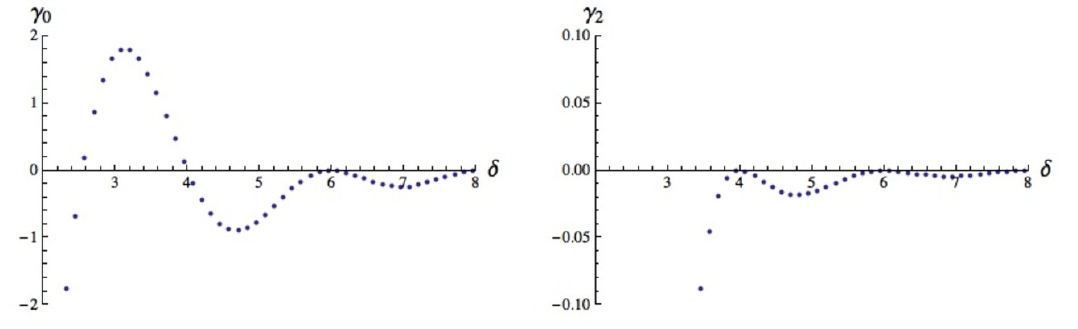
Figure 2 . Contribution to the anomalous dimension (cid:13) 0 ; 0 and (cid:13) 0 ; 2 from the exchange of an inter- mediate operator of spin zero, in units of the positive OPE coe(cid:14)cient. The behaviour of (cid:13) 0 ;‘ with ‘ > 0 is very similar to (cid:13) 0 ; 2 .